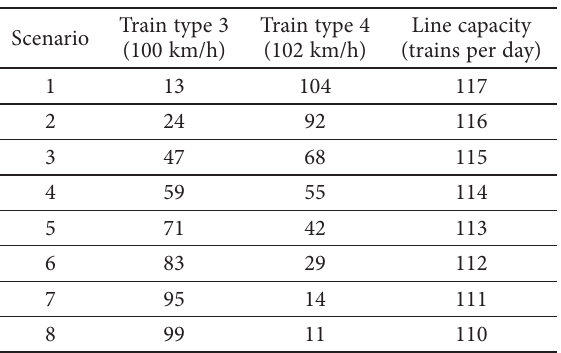
Table 3. The critical line section